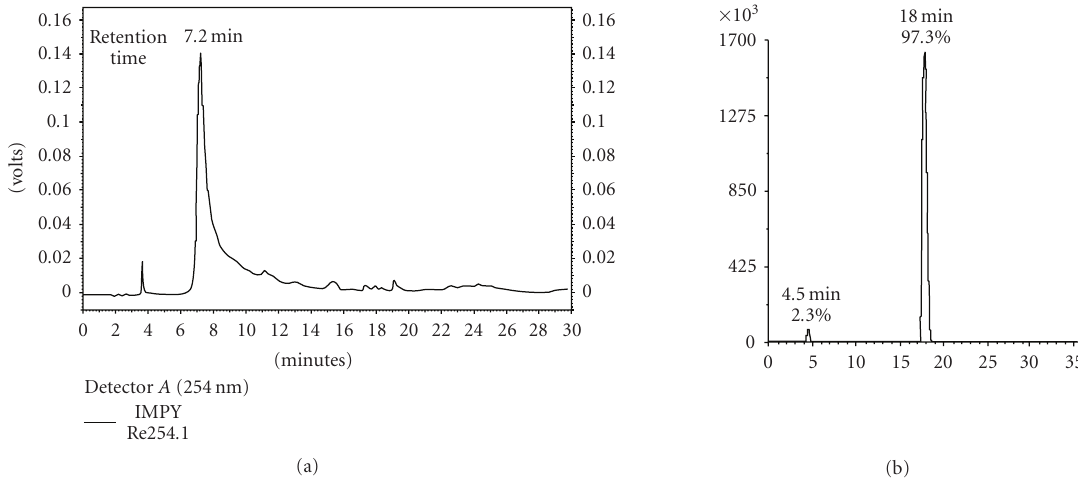
Figure 2: HPLC retention times of Re(CO) 3 (L) (a) and 99m Tc(CO) 3 (EHIDA)